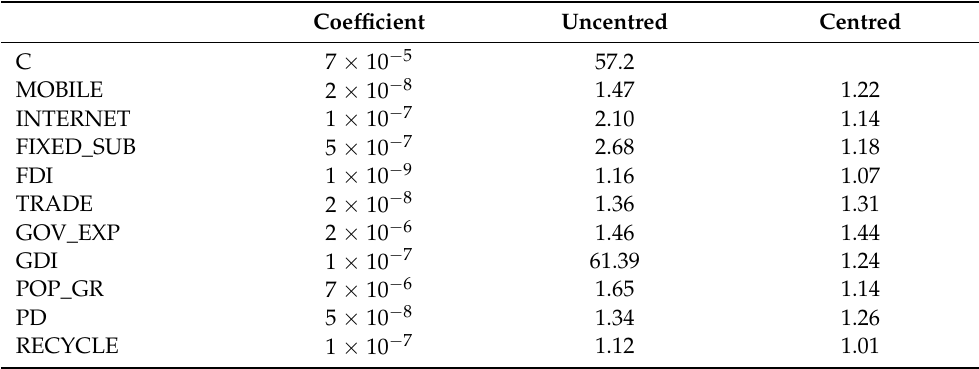
Table 5. The variance inflation factor